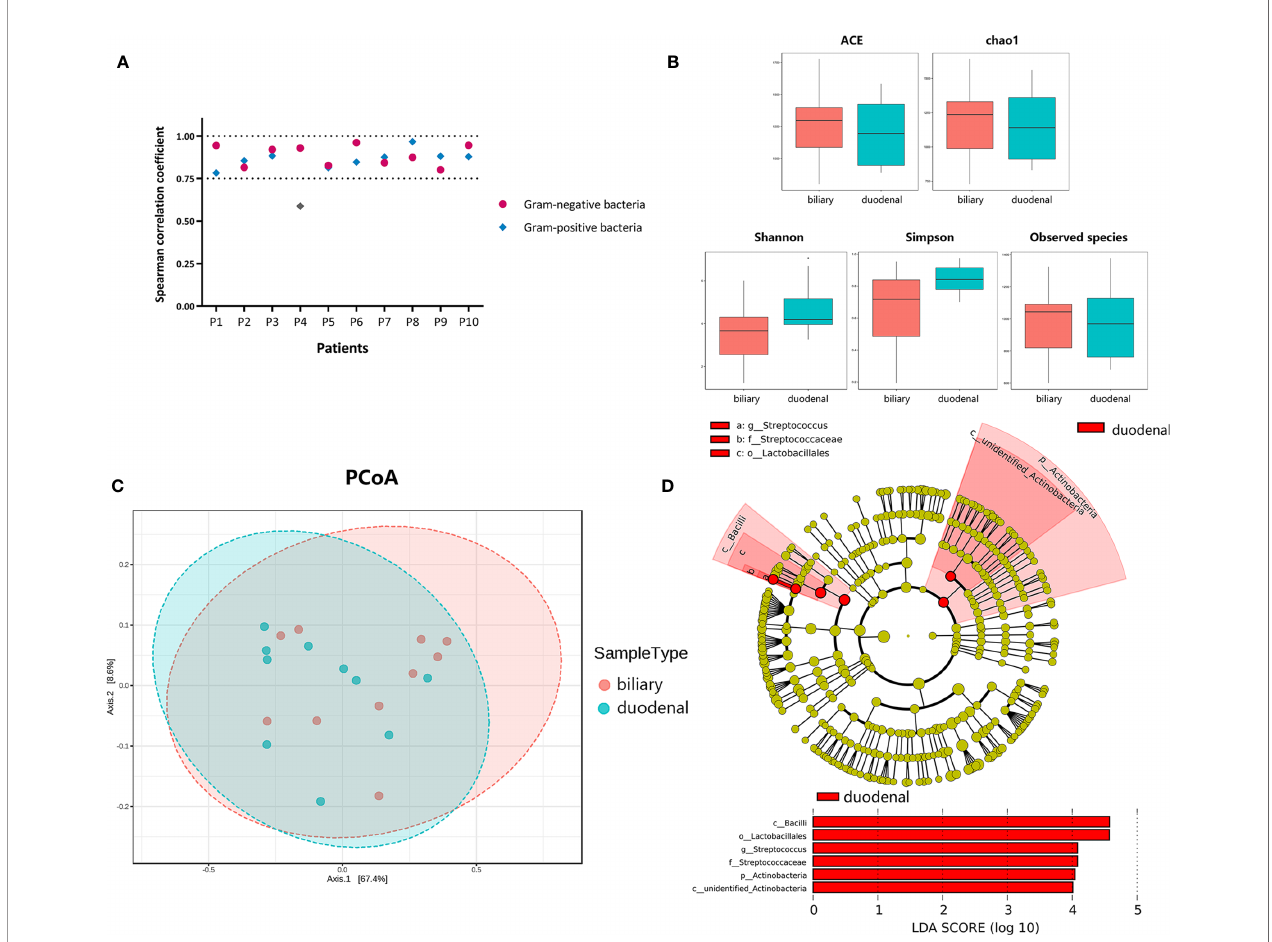
FIGURE 2 | Differences in bacterial communities of biliary and duodenal microbiota of patients with choledocholithiasis. (A) Spearman correlation coef fi cients between biliary and duodenal samples in each patient. (B) Differences of microbial alpha-diversity between biliary microbiota and duodenal microbiota. Alpha-diversity was visualized by analysis of Box plots of ACE, chao1, Shannon, Simpson, and observed species index. (C) Differences of microbial beta-diversity between biliary and duodenal microbiota in patients. Beta-diversity was visualized by analysis of principal coordinates using weighted Unifrac distances. (D) LEfSe cladogram and LDA scores of differential features between biliary and duodenal